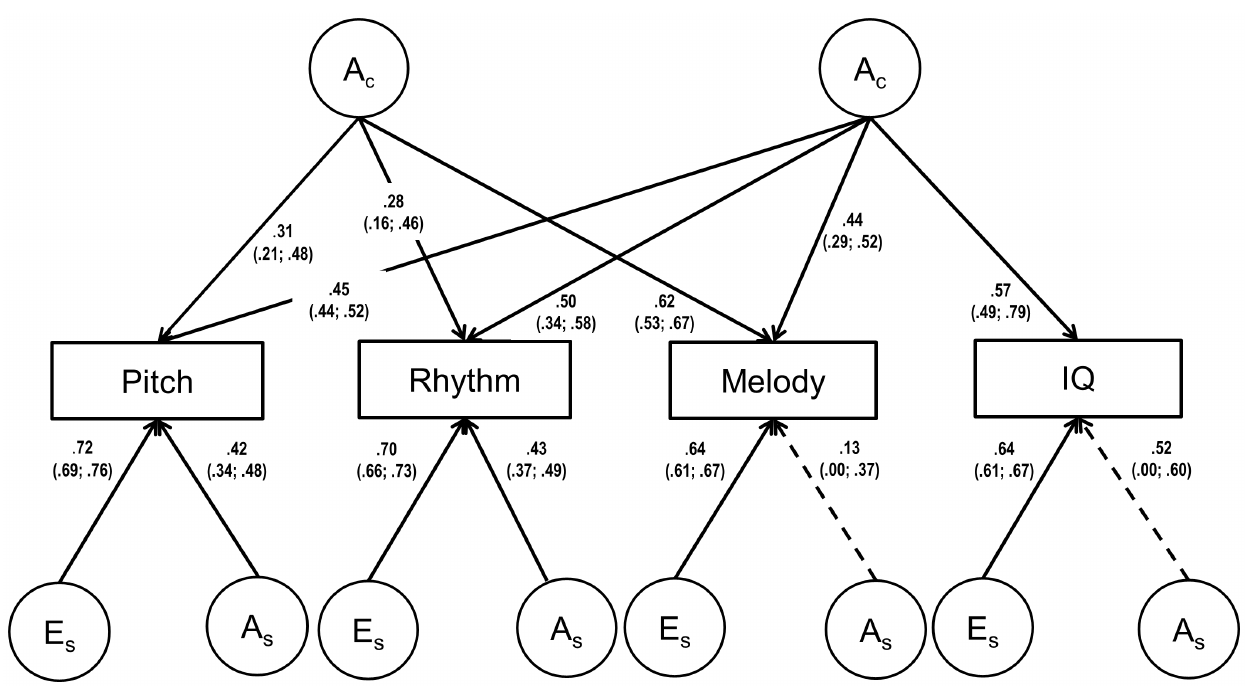
Figure 2. The reduced AE independent pathway model with two common genetic factors. Numbers represent path coefficients with confidence intervals within parentheses. Significant pathways are shown with solid lines; non-significant pathways are represented as dashed lines. A 5 additive genetic influences; E 5 non-shared environmental influences. Subscripts c and s denote common and specific influences, respectively.